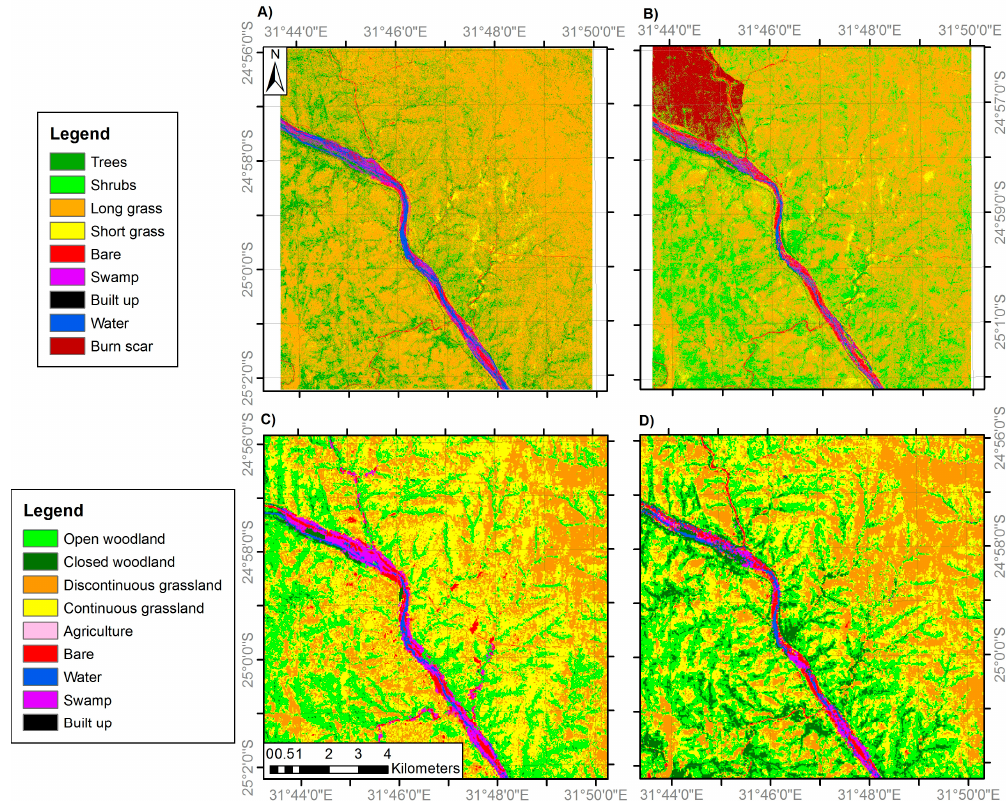
Figure 5. Land cover classifications of site 3 generated from: ( A ) VHR IKONOS imagery (4 m resolution) in 2001; ( B ) VHR IKONOS imagery (4 m resolution) in 2014; ( C ) medium resolution Landsat ETM+ imagery (30 m) in 2002; and ( D ) medium resolution Landsat OLI imagery (30 m) in 2014. Areas of ‘No Data’ correspond to areas of cloud cover and cloud shadow. Note the woodland and grassland class definitions differ between the fine and medium resolution classifications (Table 2). Table 4. Land cover change between 2002 and 2014 calculated using medium spatial resolution imagery. Note there is some overlap between sites 1 and 2. To ensure that the overlap between sites 1 and 2 was not double-counted in the ‘total’ area calculations, the part of site 1 in the overlap area (more affected by cloud) was excluded when the ‘total’ columns were calculated. Cover change % corresponds to percentage of the full site areas.